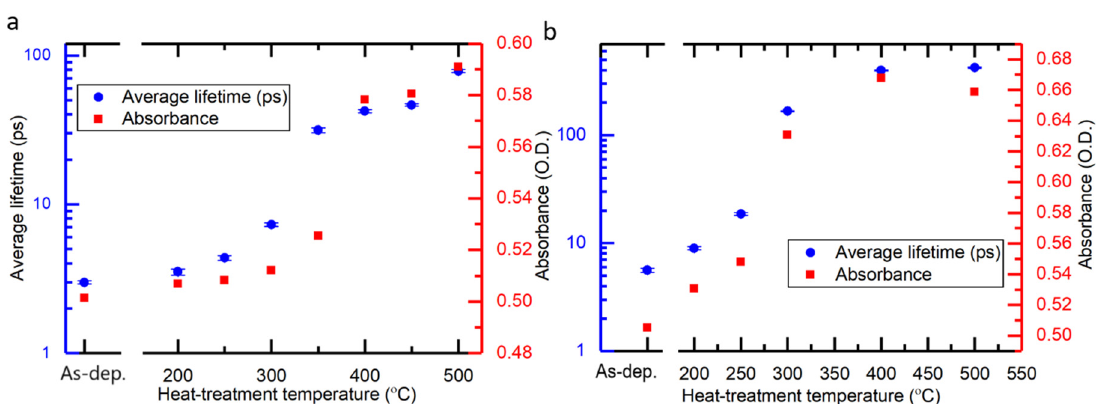
Figure 4. Average lifetime as a function of heat-treatment temperature shown along with absorbance of the samples at 320 nm from steady state spectra for samples grown at ( a ) 100 ° C and ( b ) 150 ° C.